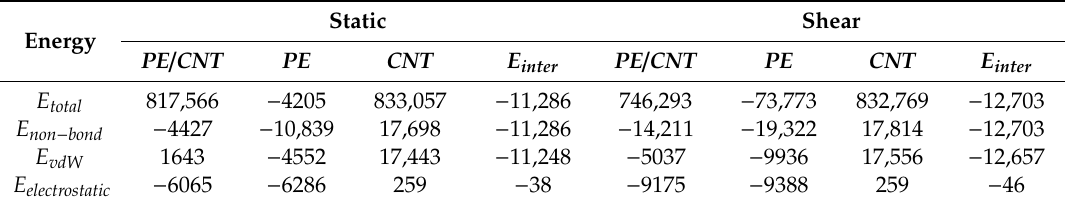
Table 1. Energy of the composite system after running for 500 ps (kJ · mol − 1 ). Static Energy